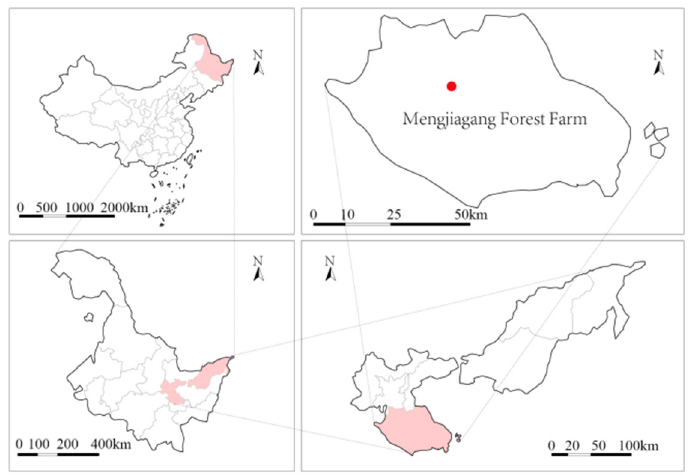
Figure 3. The site of the Mengjiagang Forest Farm.